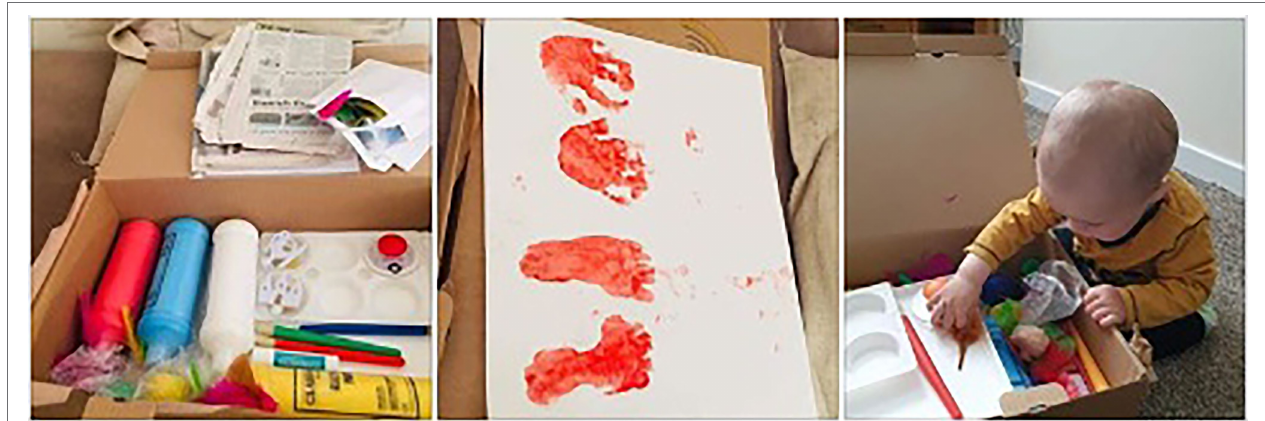
FIGURE 12 | Image shared through social media of infant opening